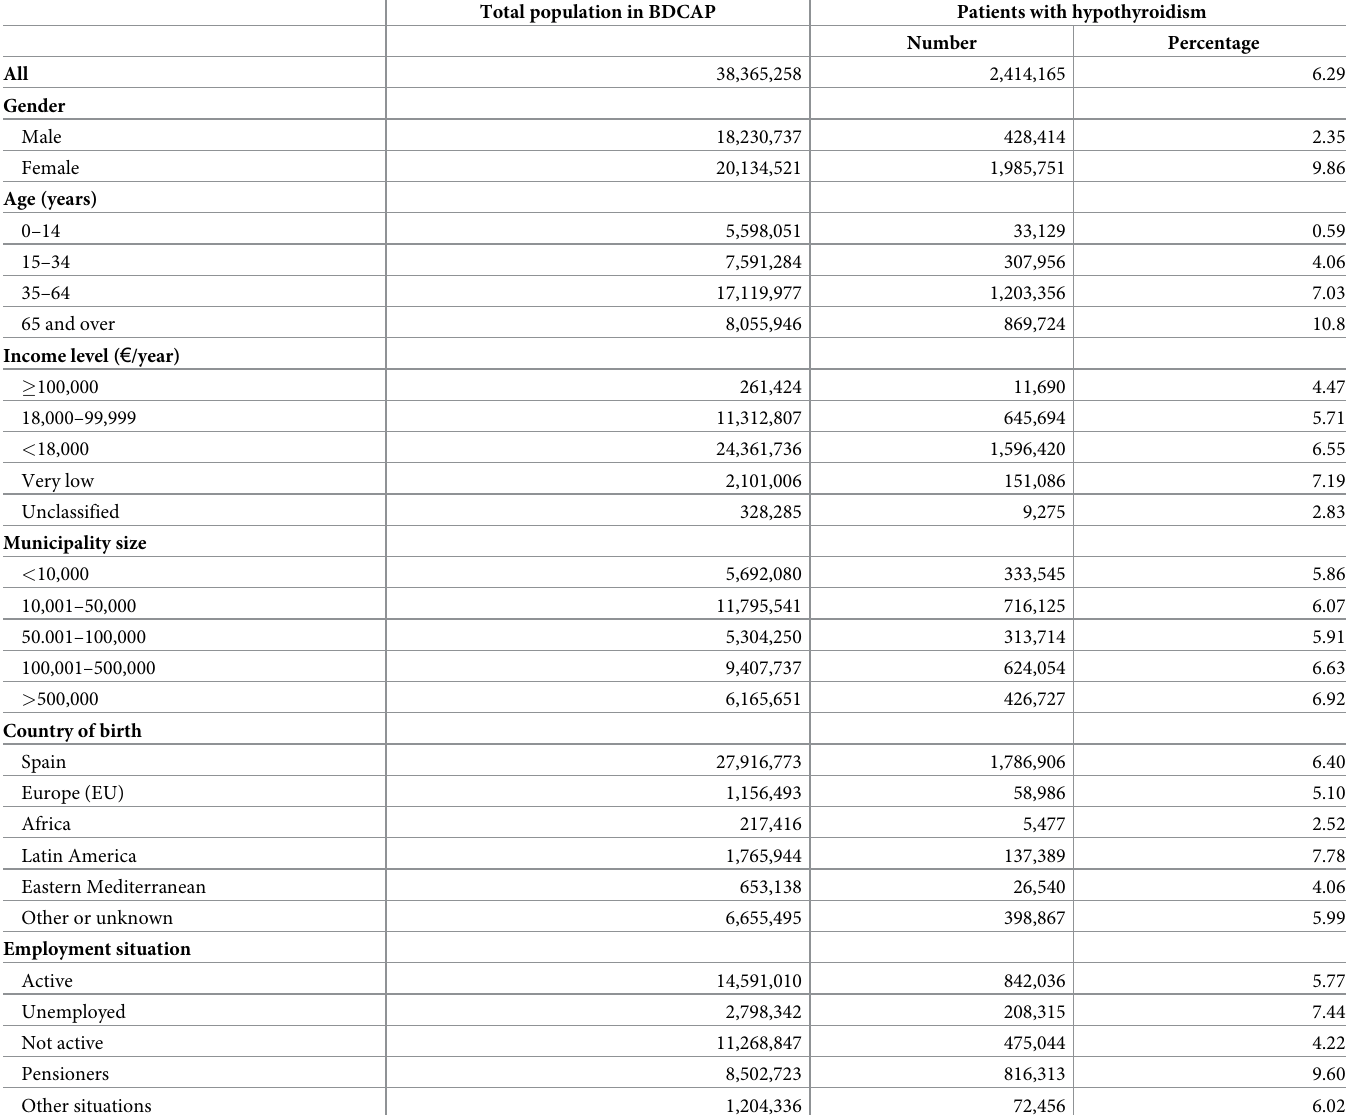
Table 1. Total population with health problems registered in the BDCAP database in 2019 and distribution of patients with hypothyroidism. Total population in BDCAP Patients with